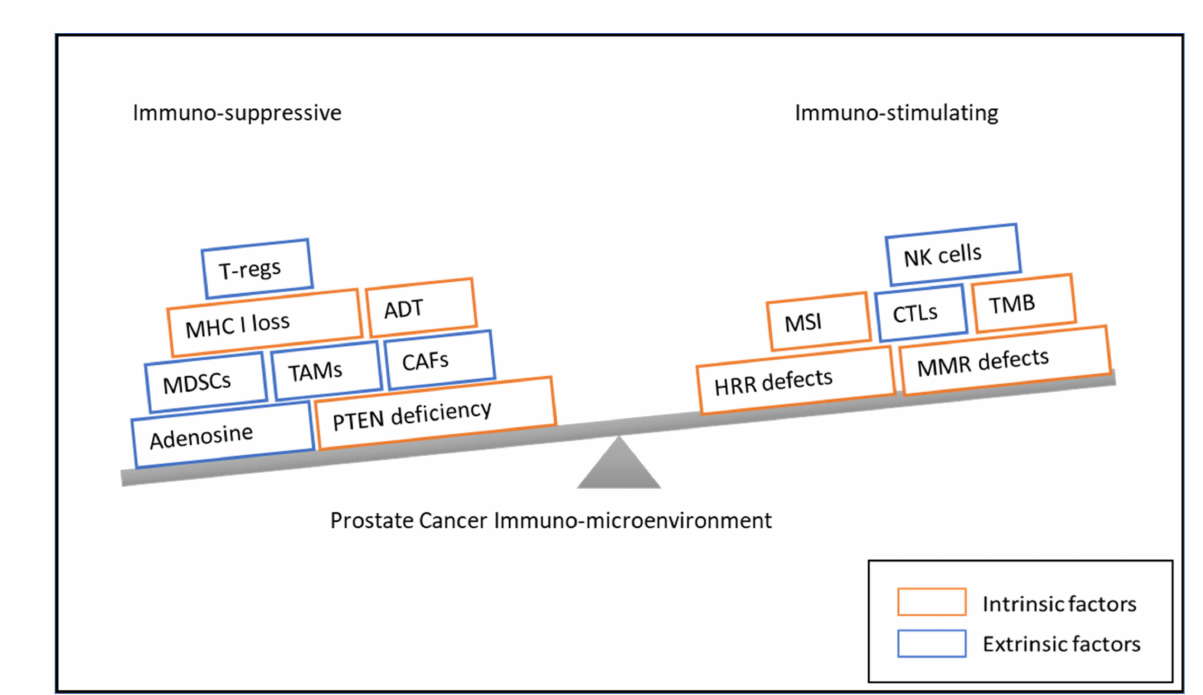
Figure 1. Immunosuppressive and -stimulating factors influencing immune response in advanced prostate cancer. Abbreviations: T-reg: regulatory T cell, MHC I: major histocompatibility complex I, ADT: androgen-deprivation therapy, MDSC: myeloid-derived suppressor cell, TAM: tumor-associated macrophage, CAF: cancer-associated fibroblast, PTEN: phosphatase and tensin homolog, NK cell: Nat- ural Killer cell, MSI: microsatellite instability, CTL: cytotoxic T lymphocyte, TMB: tumor mutational burden, HRR: homologous recombination repair, and MMR: mismatch